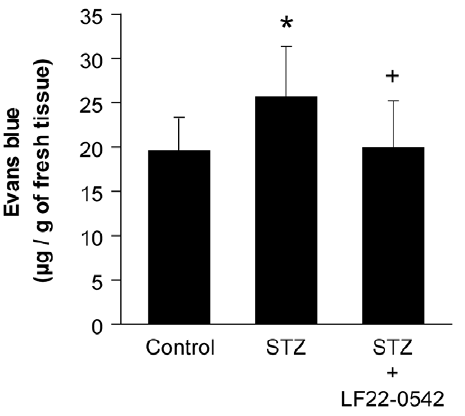
Figure 2. Effect of LF22-0542 on retinal vascular permeability in STZ-diabetic rats. Data are mean 6 s.e.m. of values obtained from 9 to 11 rats. Statistical comparison with control (*) or STZ ( + ) rats is indicated by * + P ,